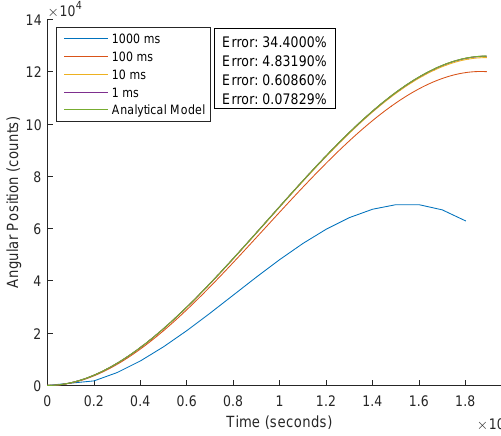
Figure 8. Simulation comparison between analytical method and numerical method for 15 turns in parabolic